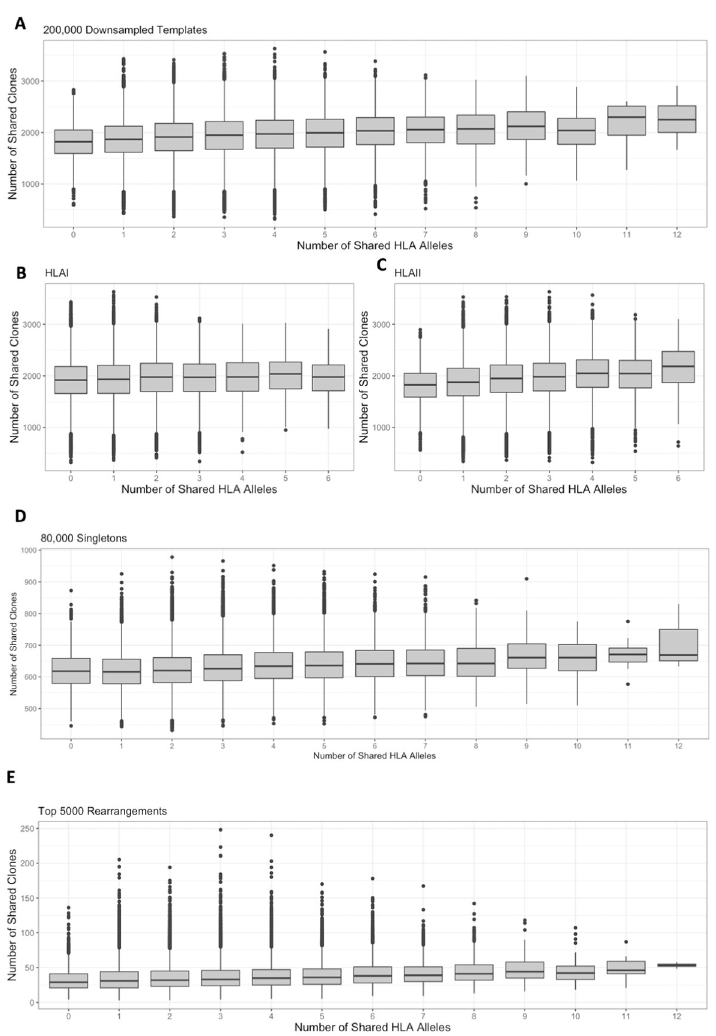
Fig 2. TCR β clone sharing is correlated with HLA allele sharing. Among repertoires computationally down- sampled to 200,000 productive templates, clone sharing positively correlated with increased numbers of (A) shared HLA alleles overall (Mantel rho = 0.17, p < 1e-3, linear mixed effects model slope = 14, intercept = 1884), and of both HLA (B) class I (Mantel rho = 0.07, p < 1e-3, linear mixed effects model slope = 9, intercept = 1920) and (C) class II alleles (Mantel rho = 0.19, p < 1e-3, linear mixed effects model slope = 21, intercept = 1881). (D) The number of singletons shared between two individuals was positively and significantly correlated with the number of HLA alleles shared (Mantel rho = 0.14, p < 1e-3, linear mixed effects model slope = 6, intercept = 613). (E) The number of clones shared among the top 5,000 unique rearrangements was positively and significantly correlated with the number of HLA alleles shared between two individuals (Mantel rho = 0.13, p < 1e-3, linear mixed effects model slope = 1.3, intercept = 34).